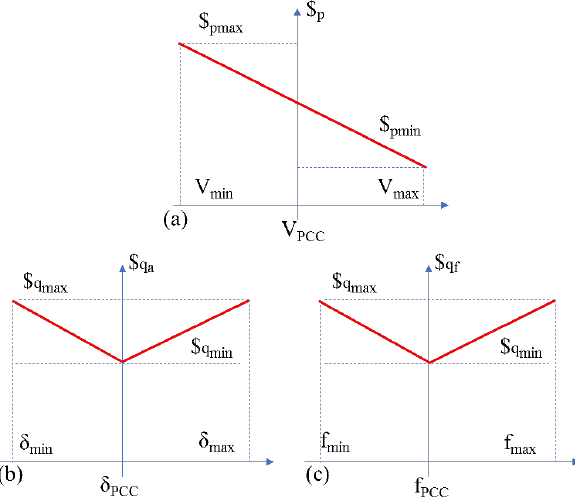
Figure 8. Relationship between parameters at the bus and power price. ( a ) Relationship between bus voltage and price. ( b ) Relationship between angle and price. ( c ) Relationship between bus frequency and